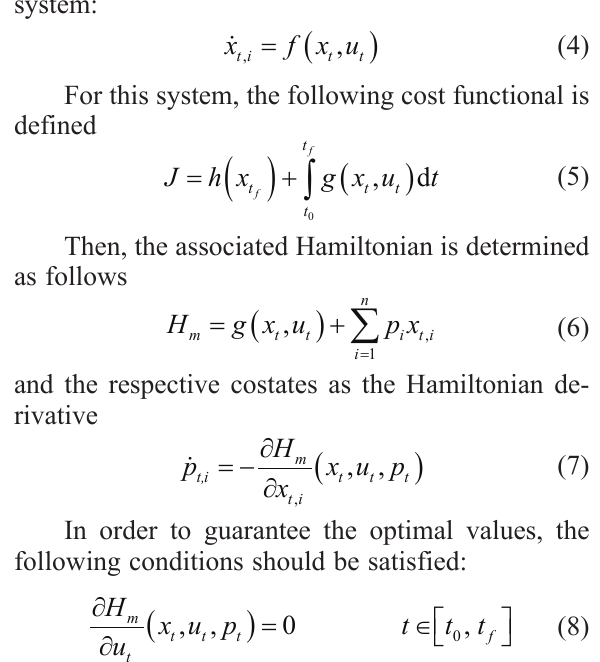
Fig. 4 – Steepest descent gradient flow